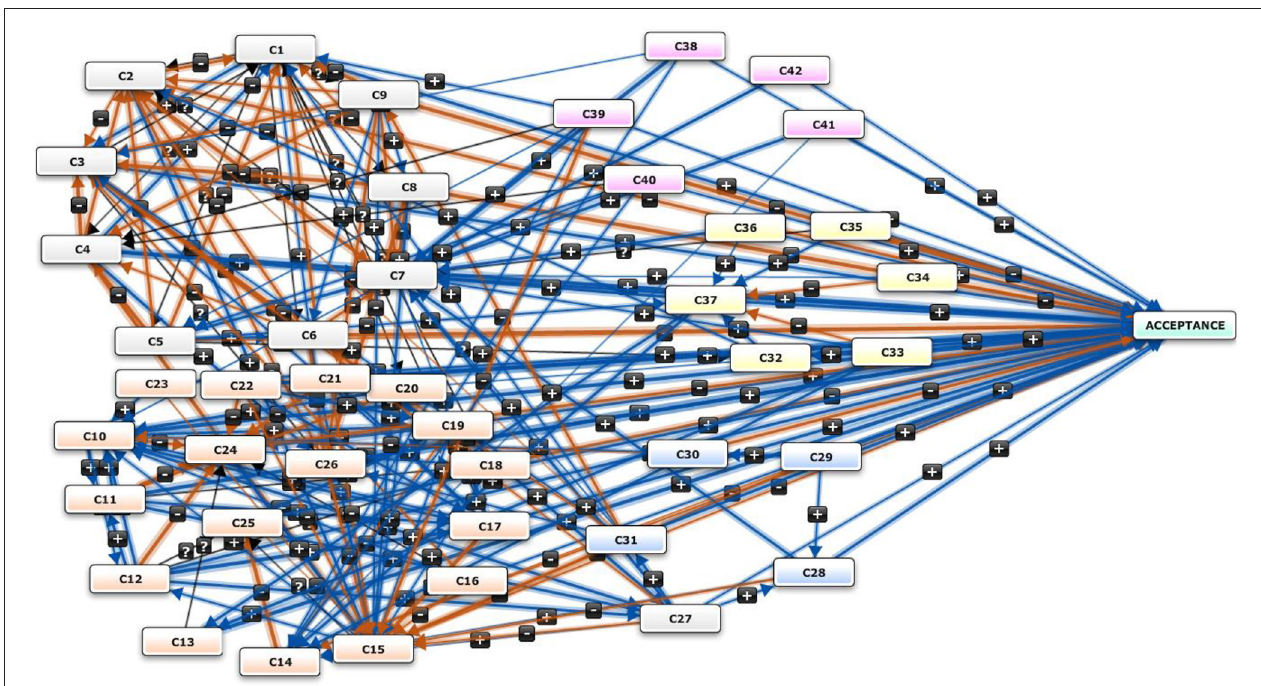
FIGURE 2 | The resulting FCM from the experts and stakeholder analysis.